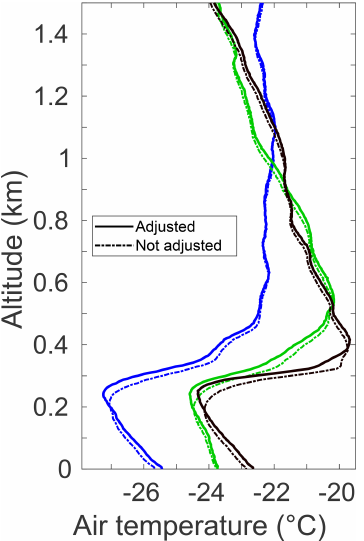
Figure 3. Air temperature data of the D1 dropsonde from 4 March (blue) and the D1 (green) and D2 (dark red) dropsondes from 26 March (see Table 2) with and without the dynamical adjustment of ASPEN (see Martin and Suhr, 2021). Only the lowest 1.5km of the profiles are